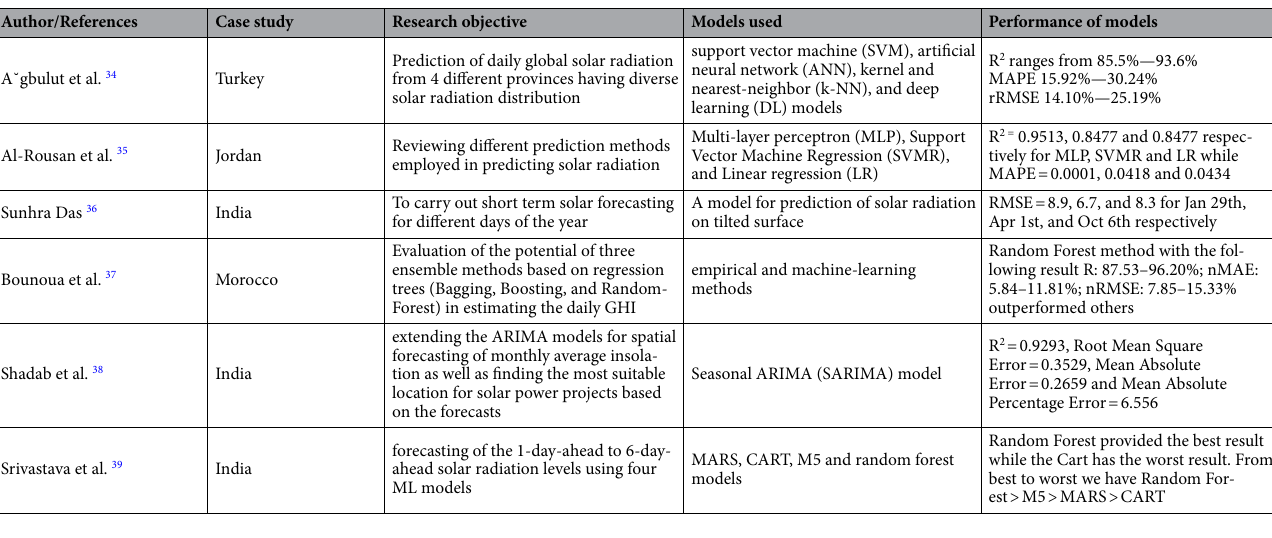
Table 1. Summary of recent literature on solar radiation forecast/prediction.